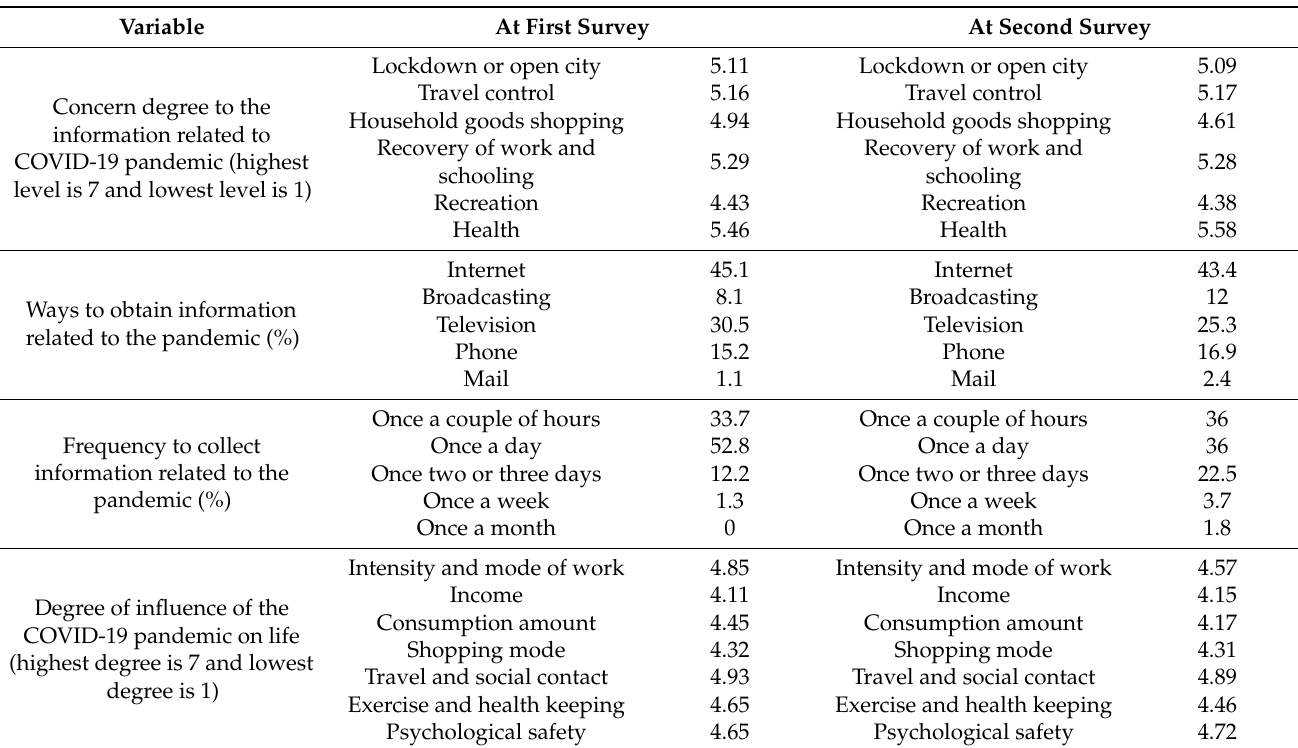
Table 7. Concerns regarding the COVID-19